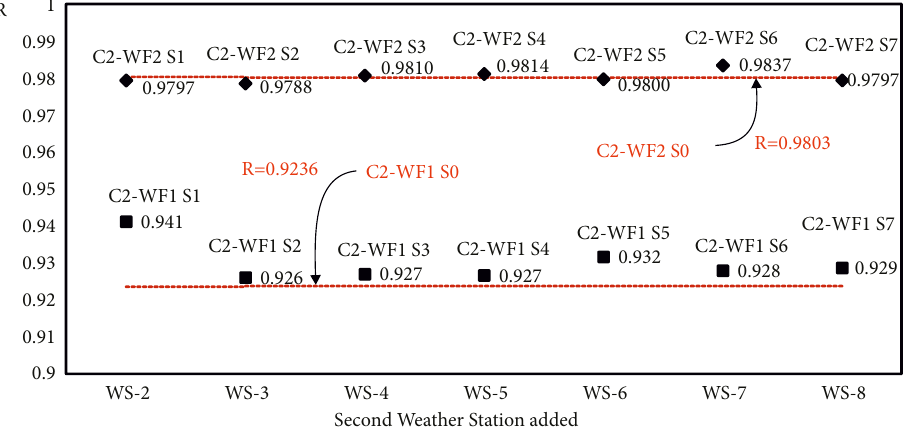
Figure 10: Comparison of the “R” results for Case 2 and Case 1 (C2-WF S0).